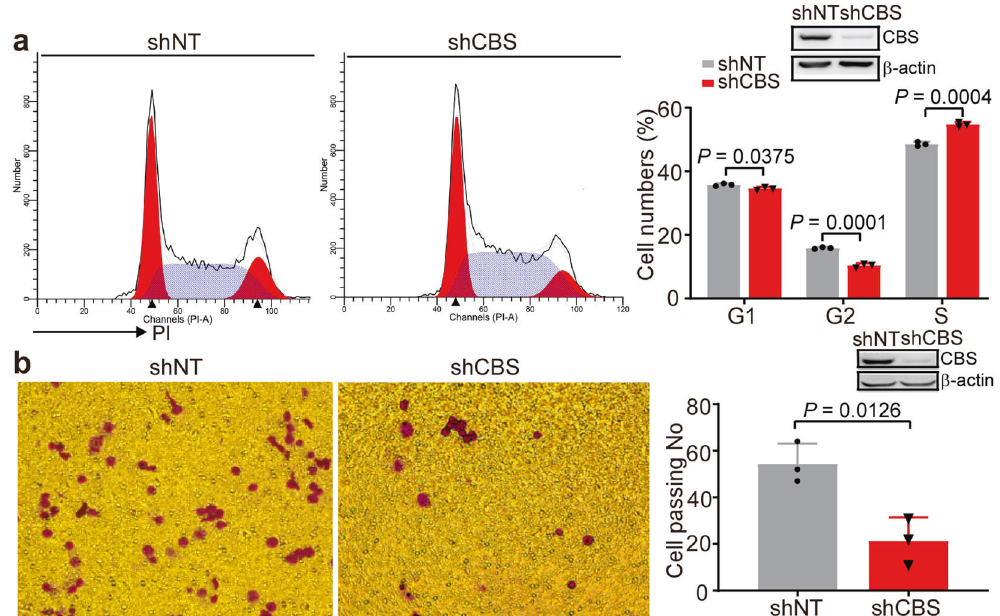
Fig. 4 Knockdown of CBS expression in K562 cells induced S-phase arrest and inhibited cell migration. a After knocking down the CBS expression, the cell cycle was analyzed with the PI staining and the number of cells in each phase was analyzed by Mot fi t ( n = 3). b Transwell assays were performed to evaluate the migration abilities of shNT-K562 and shCBS-K562 cells ( n = 3). The results are expressed as mean ± SEM. Statistical signi fi cance was determined by two-tailed Student ’ s t test